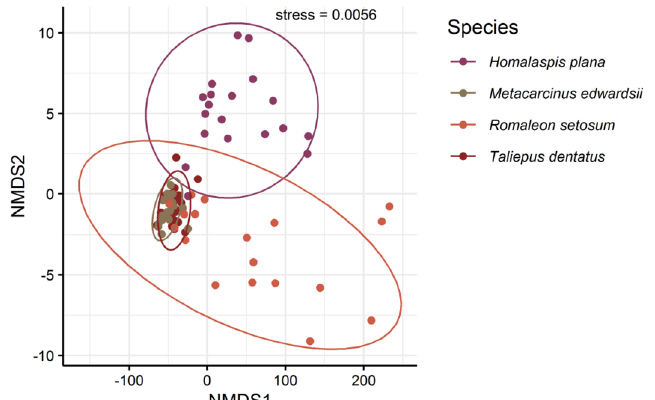
Figure 3. Non-metric multidimensional scaling (nMDS) plot consisting of seasonal data of four brachyuran species. Non-metric multidimensional scaling is a tool to assess similarity between samples when considering multiple variables of interest. The value stress represents how well points fit within the specified number of dimensions (stress < 0.05 indicates good fit). The variables included in the nMDS were quantities of proteins and lipids, the vasosomatic index and the total energy content per paired vasa deferentia. Data were square root transformed for